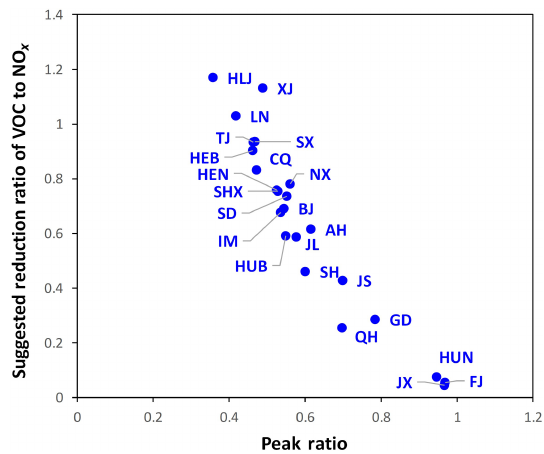
Figure 11. Comparison of the annually averaged PR with VNr in each province in